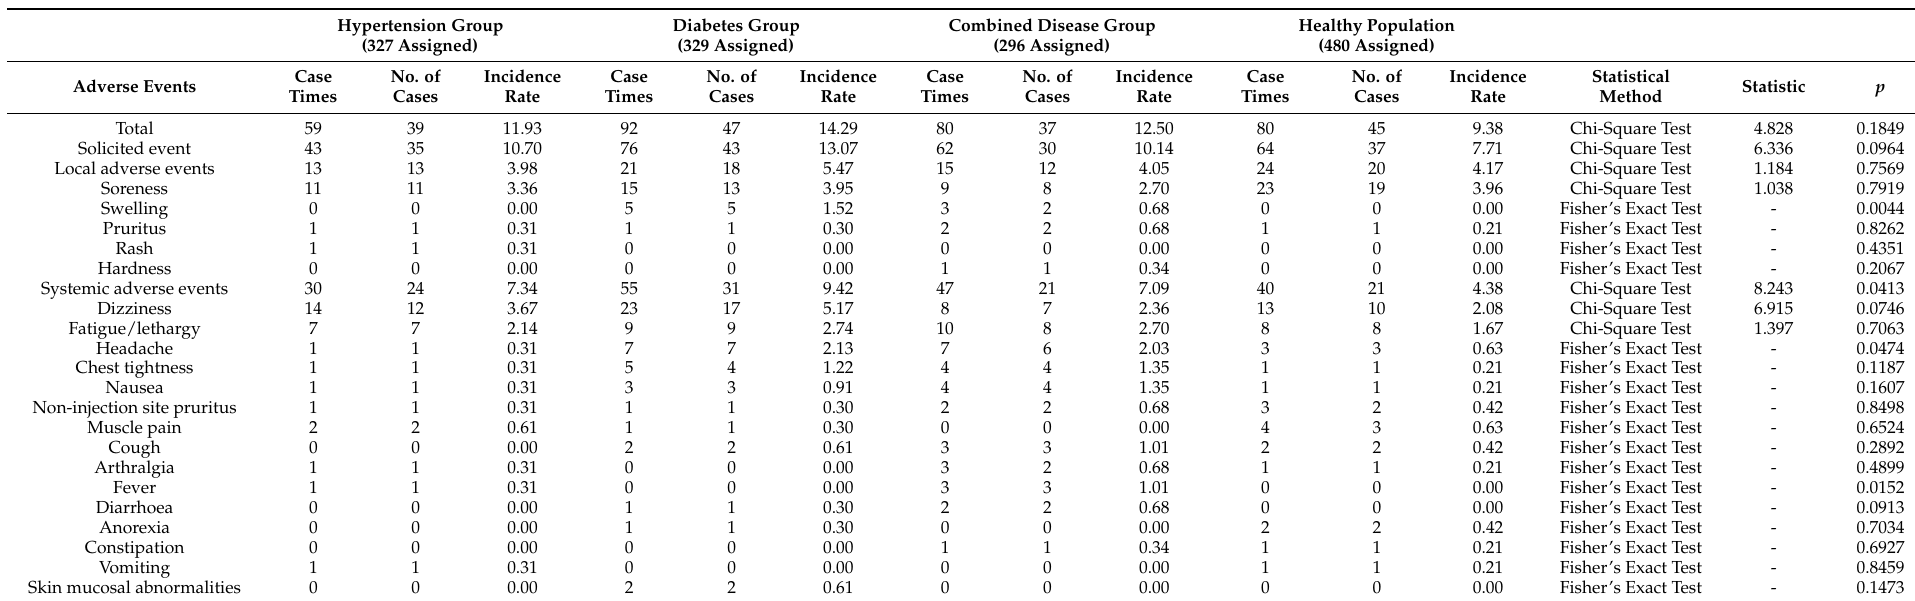
Table 2. Adverse events related to the study vaccine 0–21 days after two doses of vaccine in the whole